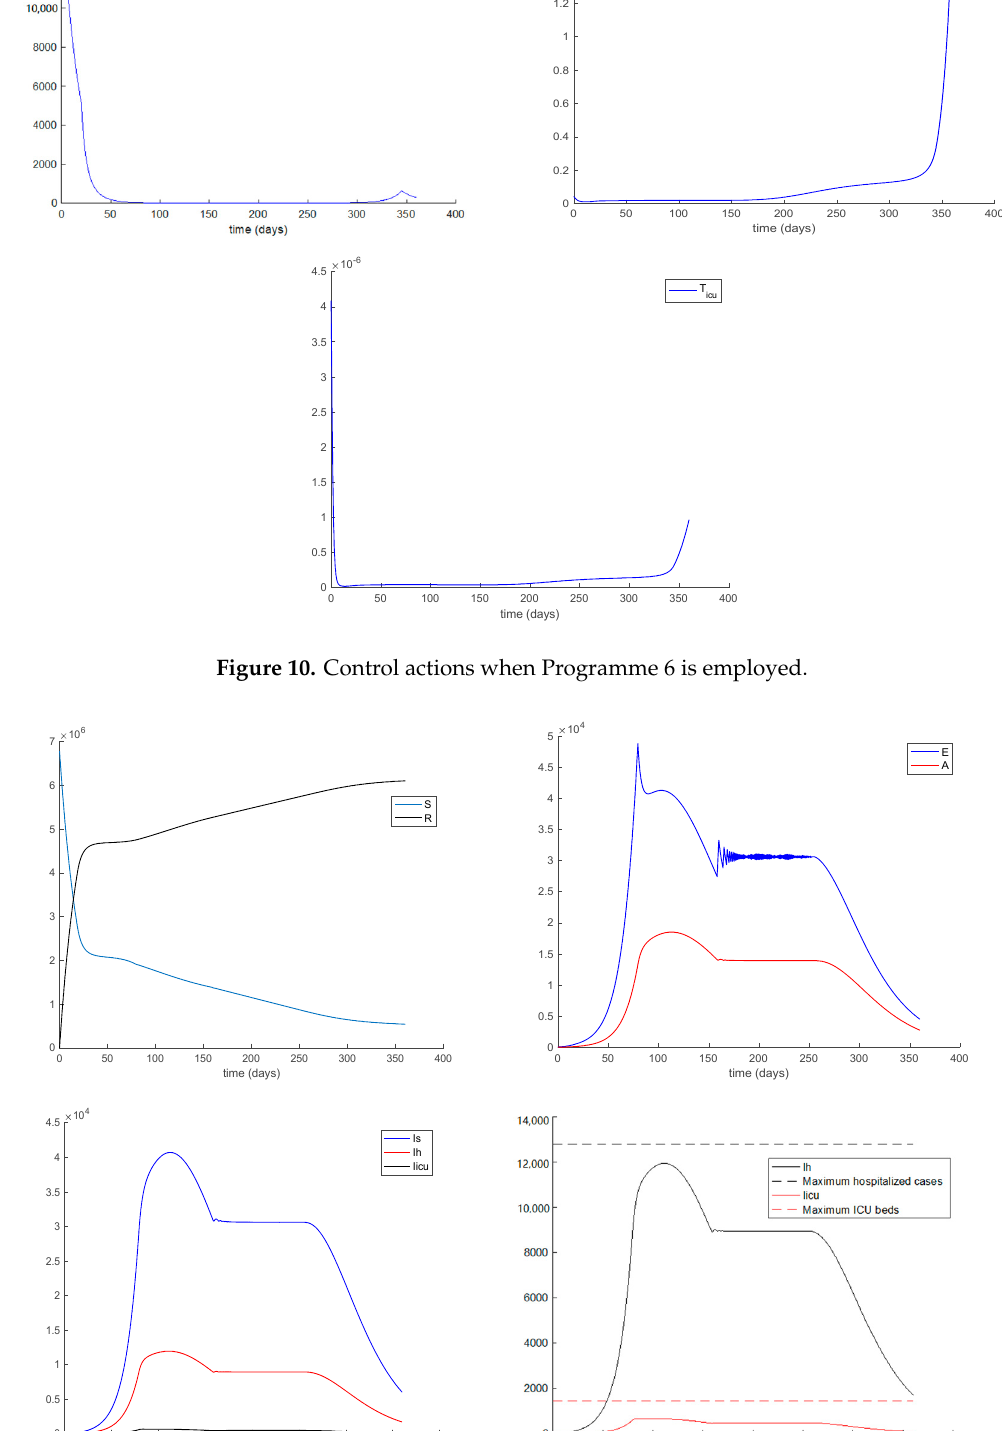
Figure 11. Evolution of all population when Programme 6 is employed with β being a control variable.